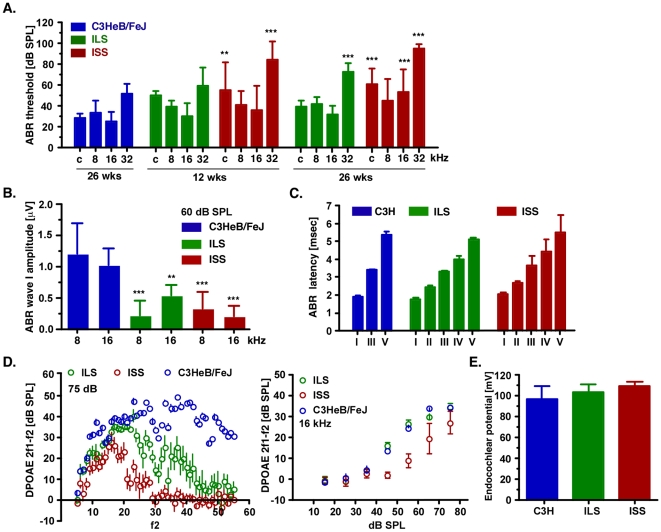
Auditory characteristics of ILS and ISS mice.
A. ABR thresholds at click (c) and pure tone pips at 8-, 16-, and 32 kHz at twelve and 26 weeks (wks) of age. Data are given as mean ± SD. B. Wave I ABR amplitudes at 8- and 16 kHz stimuli at 60 dB SPL input levels. Data are given as mean ± SD. µV, microvolt. C. Latencies of ABR waves I – V at a 16 kHz stimulus of 60 dB SPL. Data are given as mean ± SD; msec, milliseconds. D. DPOAE output levels at 2f1-f2 in dB SPL over f2 frequency range 6–56 kHz (left panel). The right panel shows I/O function at f2 = 16 kHz. Data are given as mean ± SEM. E. Endocochlear potentials. Data are given as mean ± SD; mV, milliVolt. For all panels: C3HeB/FeJ (blue), ILS (green) and ISS (red); **p<0.01; ***p<0.001.